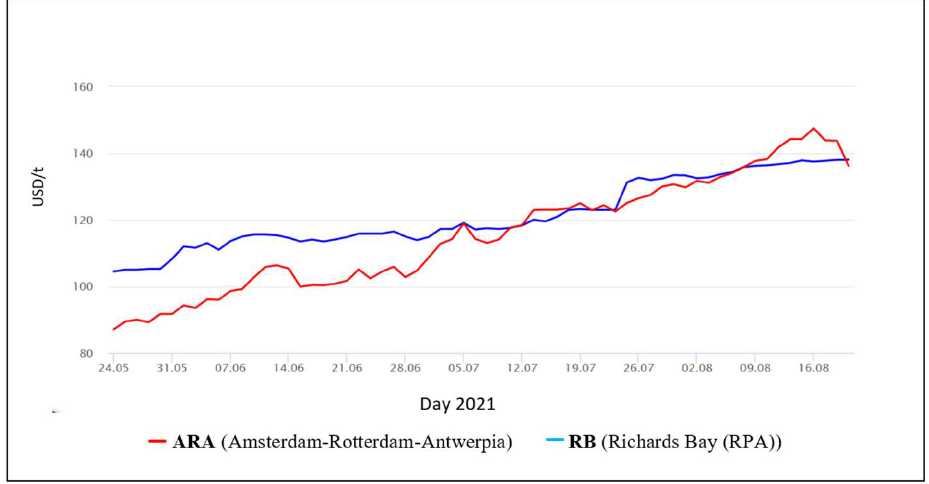
Figure 6. The evolution of coal prices in May–August 2021, source: own study based on [23].